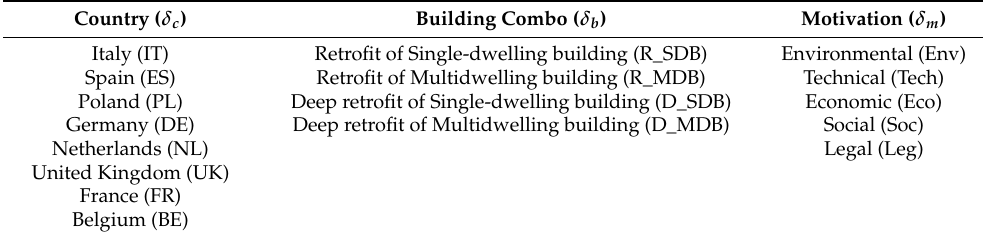
Table 7. Definition of binary variables (and respective variable